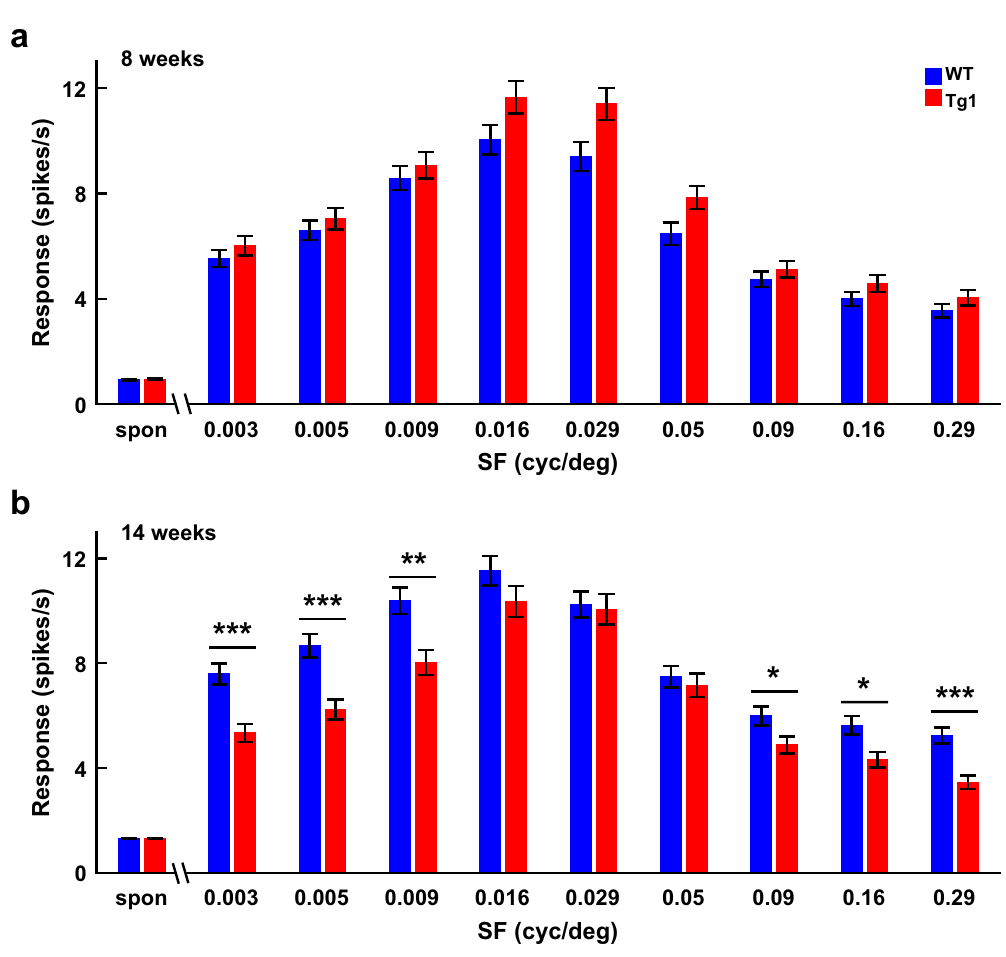
Figure 4. Comparison of spontaneous and evoked responses to each SF between V1 neurons in WT and Tg1 mice. ( a ) Spontaneous and evoked responses for V1 neurons in WT and Tg1 mice at 8 weeks. ( b ) Spontaneous and evoked responses for V1 neurons in WT and Tg1 mice at 14 weeks. Error bars, ± s.e.m., * P < 0.05, ** P < 0.01, *** P < 0.001, two-way ANOVA with mixed design, followed by Tukey’s multiple comparison test. n = 255 neurons from 27 WT mice at 8 weeks, n = 267 neurons from 22 WT mice at 14 weeks, n = 279 neurons from 29 Tg1 mice at 8 weeks, n = 153 neurons from 13 Tg1 mice at 14